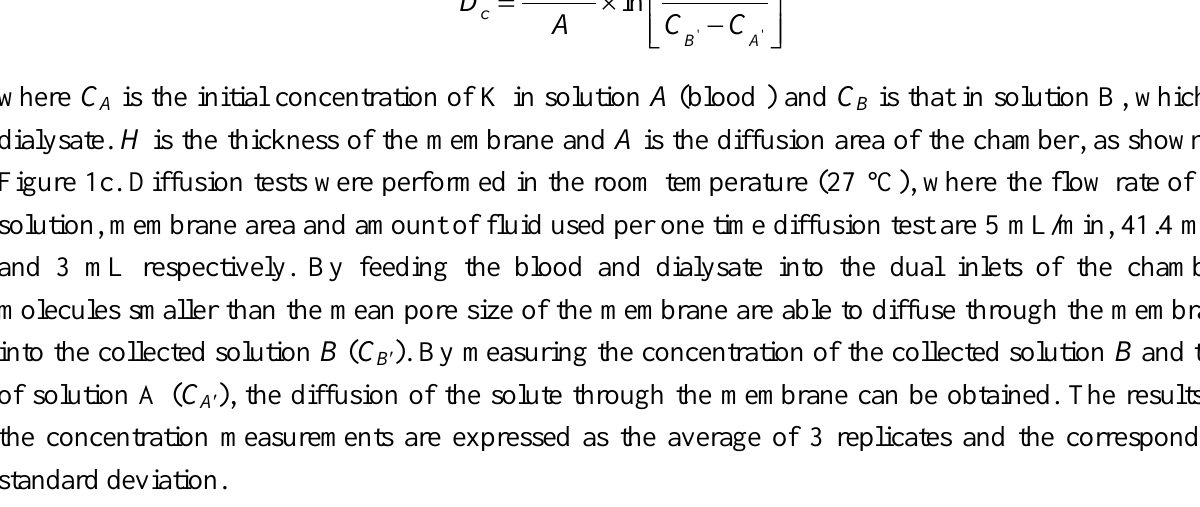
Table 2. Electrolyte values before and after diffusion test on the polyethersulfone (PES) membrane.